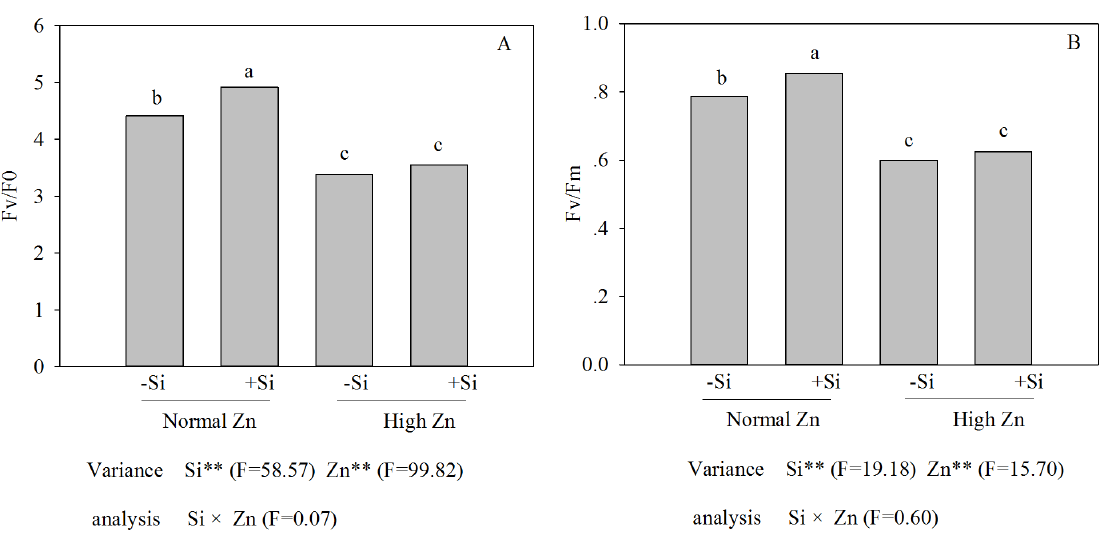
Figure 5. F v /F 0 (A) and F v /F m (B) of Zn-sensitive rice ( Oryza sativa L.) cultivar grown hydroponically with either normal (0.15 m M) or high (2 mM) Zn without or with 1.5 mM Si for seven days. Data are means ¡ S.D. of three replicates. Note:P-values indicate significance level based on two-way ANOVA. * P , 0.05, ** P , 0.01. Data followed by different letters are significantly different according to ANOVA (P ,